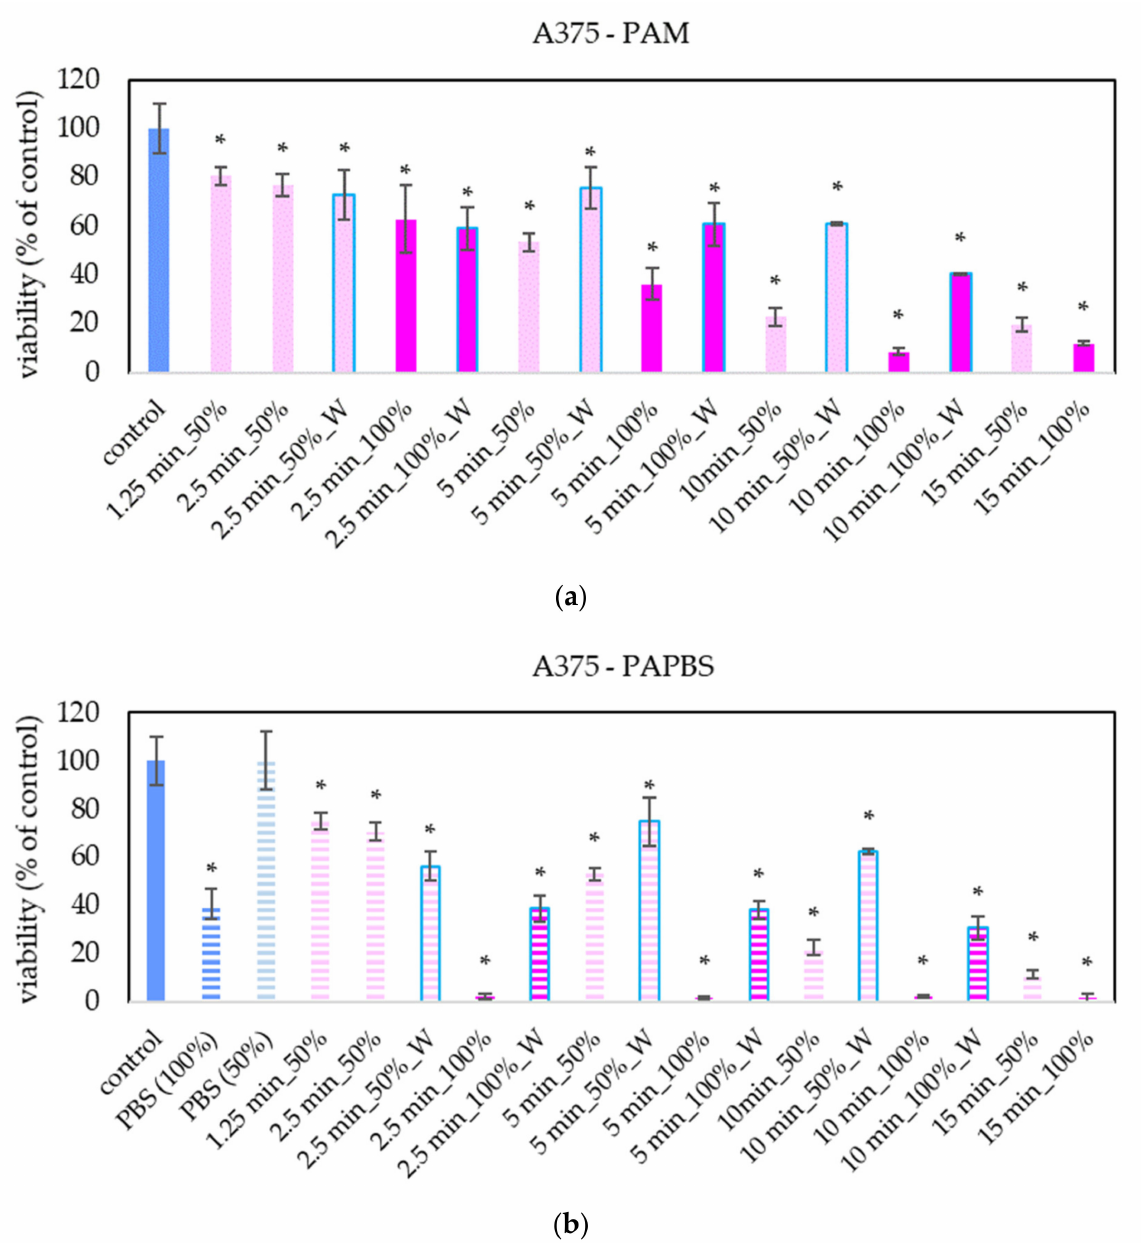
Figure 2. Effect of PAL on cell viability of human melanoma cells A375 24 h after PAL application. Plasma-activated medium (PAM) ( a ) or plasma-activated PBS (PAPBS) ( b ) activated for 1.25, 2.5, 5, 10 or 15 min at 100% or 50% (1:1 dilution) concentration were used. Time of PAL action was 24 h (without blue frames) or 30 min, after which PAL were replaced with untreated medium (“washing”, W, blue frames). The significant results ( p < 0.05) are marked with *. 100% PAPBS, resp. 50% PAPBS was tested compared to in 100% PBS, resp. 50% PBS, significance of other samples compared to control. Viability was normalized to the control cells incubated in the